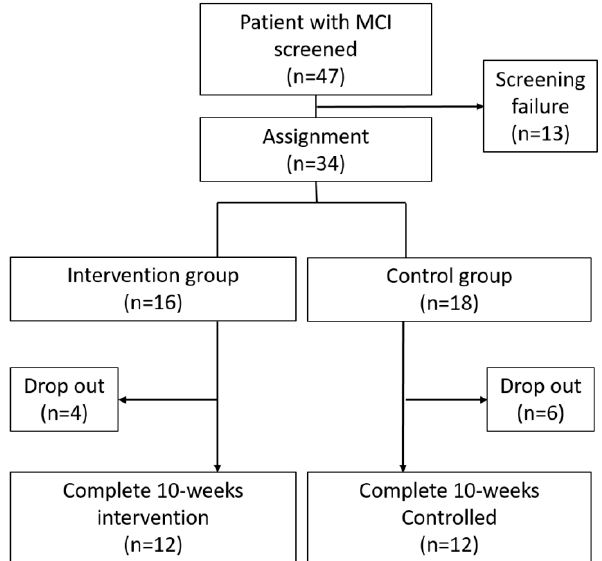
Figure 1. Flowchart showing the process of study enrollment. Forty-seven patients with mild cognitive impairment were recruited for this study and thirty-four patients were selected to be randomly assigned to the intervention (n = 16) and control (n = 18) groups. Four patients in the intervention group and six patients in the control group dropped-out. Finally, 24 patients (12 patients in the intervention group and 12 patients in the control group) completed the study protocol.